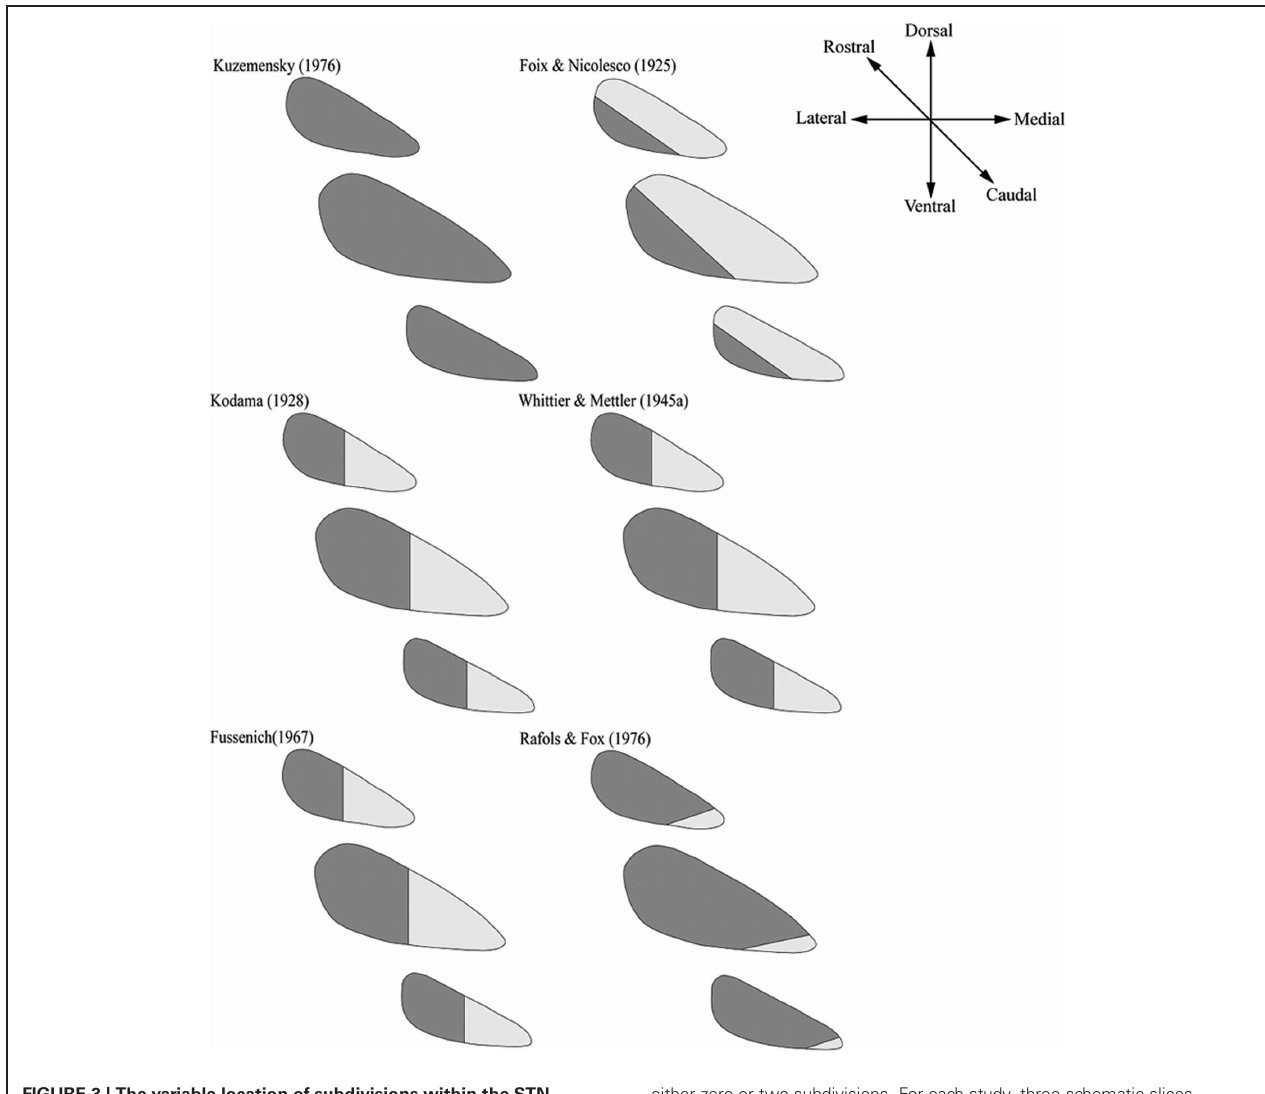
FIGURE 3 | The variable location of subdivisions within the STN based on six individual studies using classical cytoarchitectonic features. Six human and nonhuman studies are shown that argue for